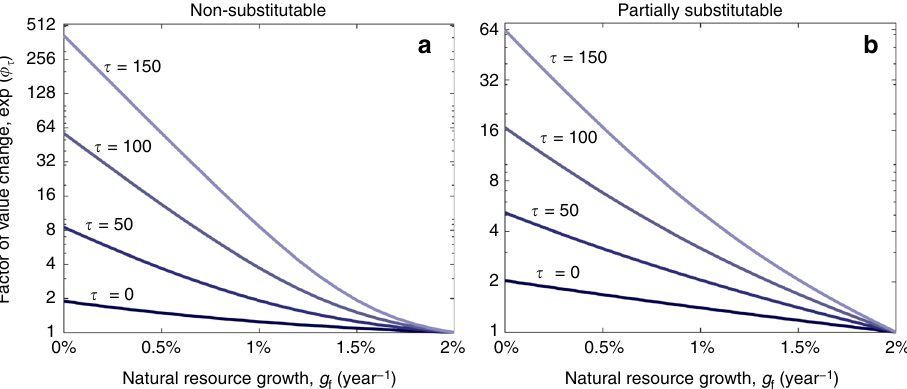
Fig. 5 Endogenizing changes in harvest patterns implies a larger discount factor and higher values for future environmental goods. If a policymaker considers a gradual transition to sustainable harvest that would occur within τ years, then he/she may consider a sustainable discount rate, δ sus , starting from year τ . In addition, however, he/she needs to add to Δ another factor, ϕ τ , that accounts for the decline in the cumulative discount that will follow due to over-harvesting prior to time τ (Eqs. 2, 3 and Fig. 4). This factor may impose signi fi cantly higher values on future goods, e.g., over two times higher if τ = 50 years and g = 1% year − 1 (exp( ϕ fi cantly higher for higher values of τ or lower values of g τ ) > 2 in both panels a and b ) and even signi f f . However, if the long-term provision of the natural resource continues to increase at the same rate as the other goods, i.e., g f = g c = 2% year − 1 , then δ sus = δ today and ϕ τ = 0 (Eq. 3). The other parameter values are the same as in Fig. 4 (Parameter values and Source data are provided as a Source Data fi